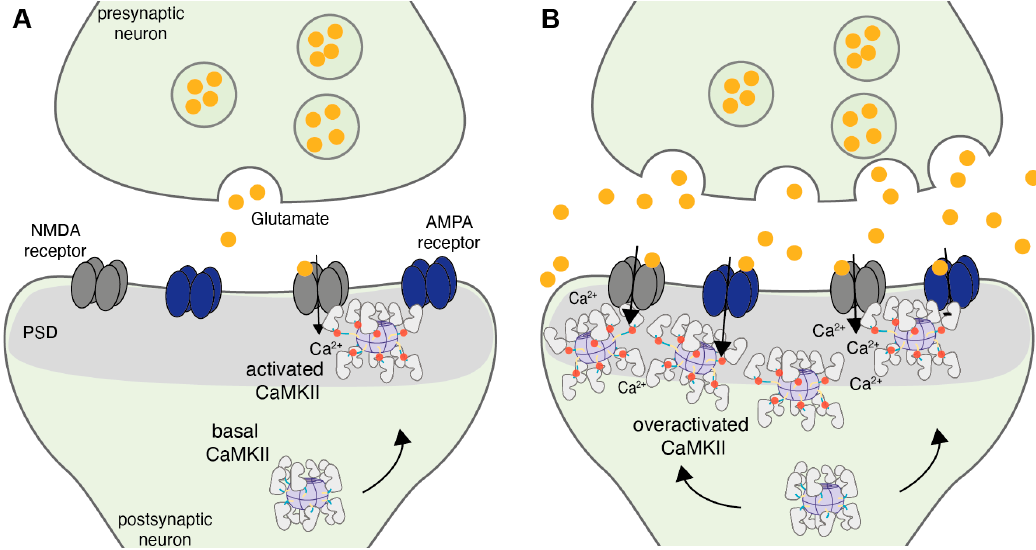
Figure 3. CaMKII translocation under physiological and ischemic conditions [21]. ( A ) Physiological synaptic activity at excitatory glutamatergic neurons leads to Ca 2+ influx through NMDA receptors. Subsequent Ca 2+ /CaM binding leads to CaMKII autophosphorylation at Thr286 and induces its translocation from the center of the dendritic spine to the post-synaptic density (PSD). Here, CaMKII co-localizes with NMDA receptors, positioning the holoenzyme in proximity to multiple substrates, such as AMPA receptors. ( B ) Ischemia leads to excitotoxicity concomitant with the excessive release of glutamate, overstimulation of glutamate receptors and intracellular Ca 2+ overload. Increased Ca 2+ influx rapidly activates CaMKII and leads to excessive autophosphorylation and translocation to the PSD.